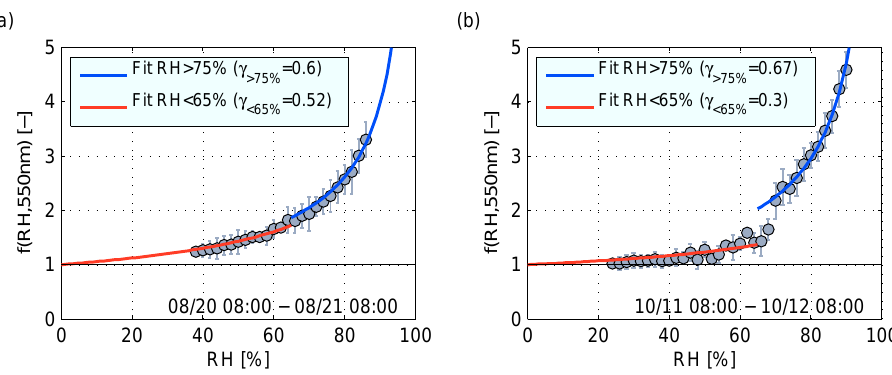
Fig. 6. Measured humidograms of f ( RH, λ = 550nm), given as daily median values, where the error bars denote the standard deviation. (a) : Example from 20 August 2008. (b) : Example from 11 October 2008. Solid lines are γ -fits for the values with RH > 75% (blue line) and for RH < 65% (red line). The time periods correspond to the filter sampling time (local